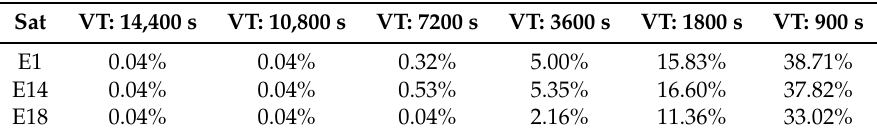
Figure 12. RMS SISE orbit on DOYs with higher errors (DOYs 61–65, 71, and 175–178) plotted versus the validity time threshold used. Milena (E14) and Doresa (E18) and satellite 1 (E1) satellites are represented by blue, red and yellow lines, respectively. Table 5. Percentage of discarded epochs, DOYs 52–71.